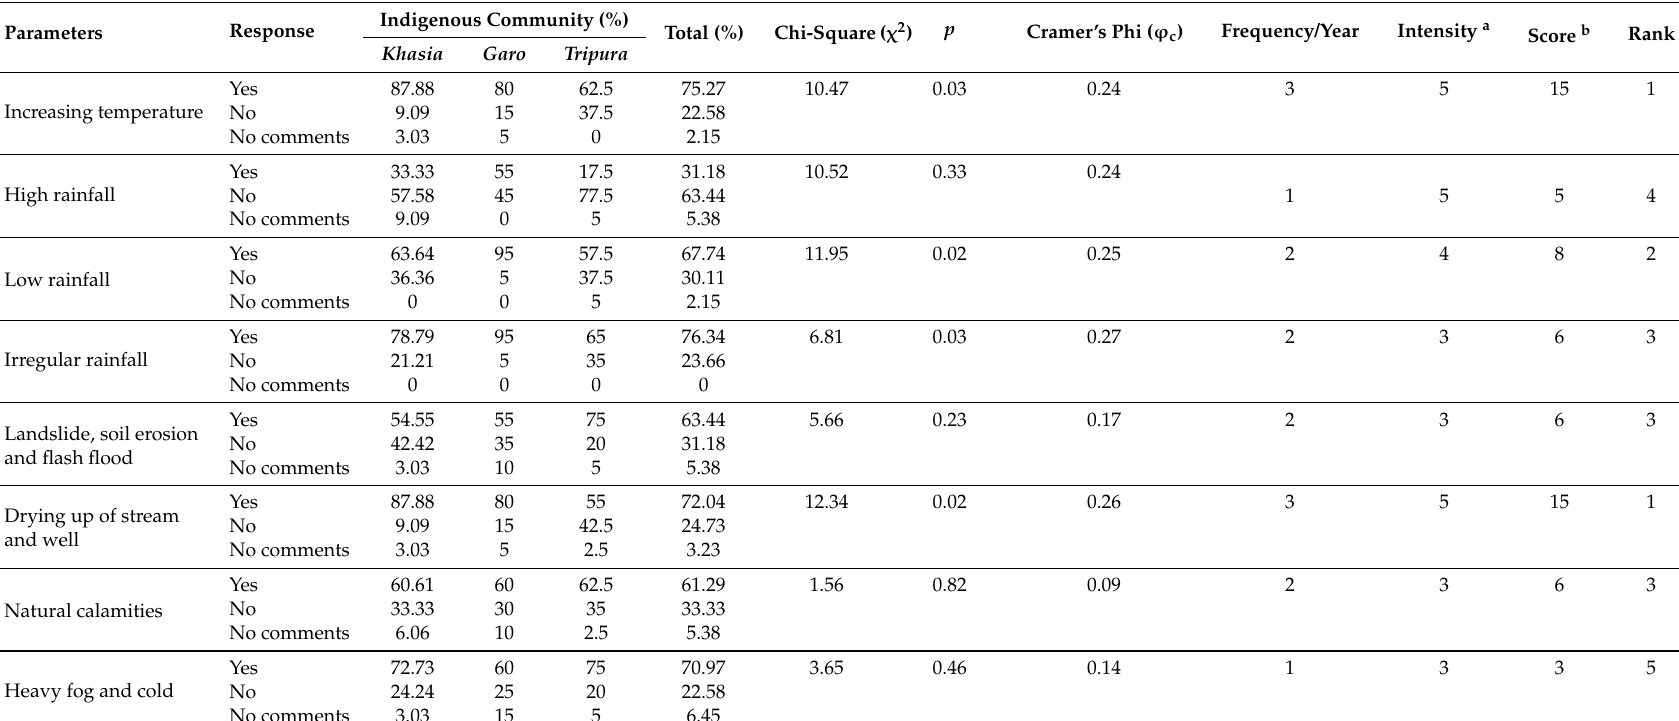
Table 3. Climatic risks observed by three indigenous communities and their ranking